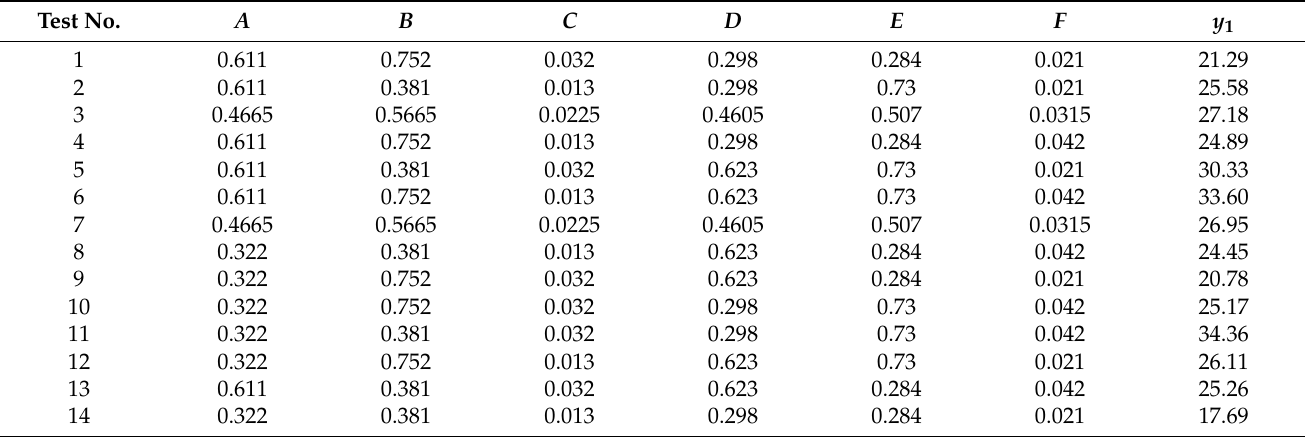
Table 3. Results of Plackett–Burman simulation test of rape stems’ contact